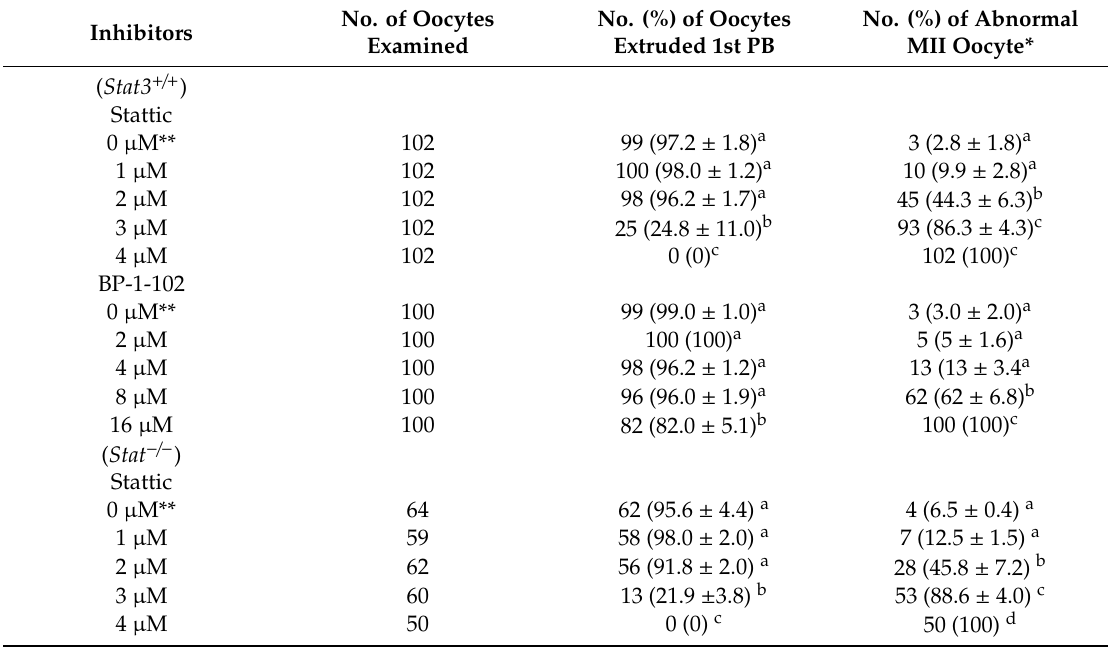
Table 1. E ff ects of the pStat3 inhibitors, Stattic, and BP-1-102, on in vitro maturation. No. of Inhibitors